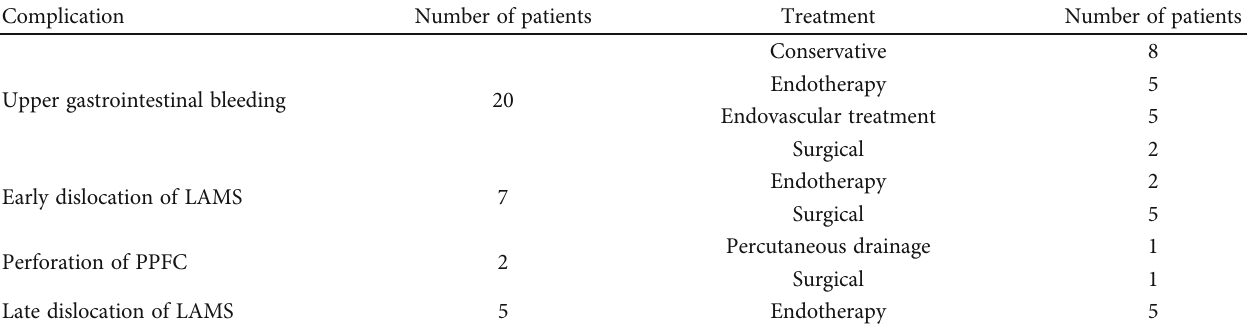
Table 3: Complications of endoscopic treatment of patients with pancreatic fl uid collections.